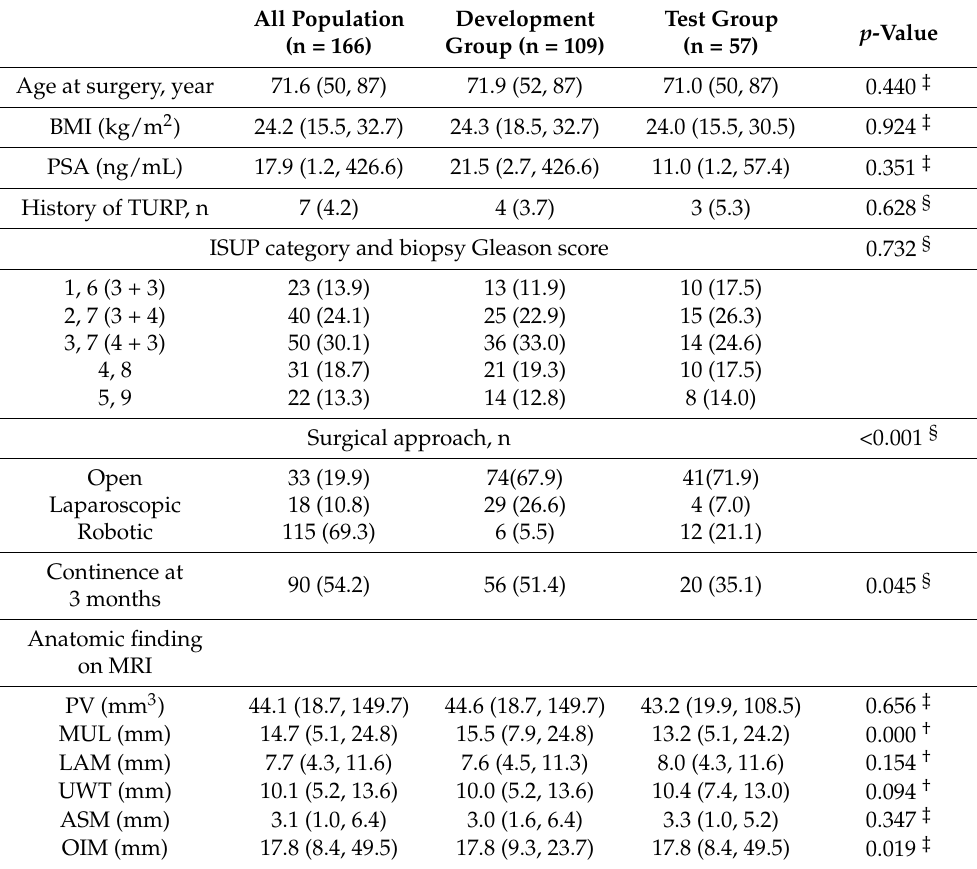
Table 2. Baseline characteristics of